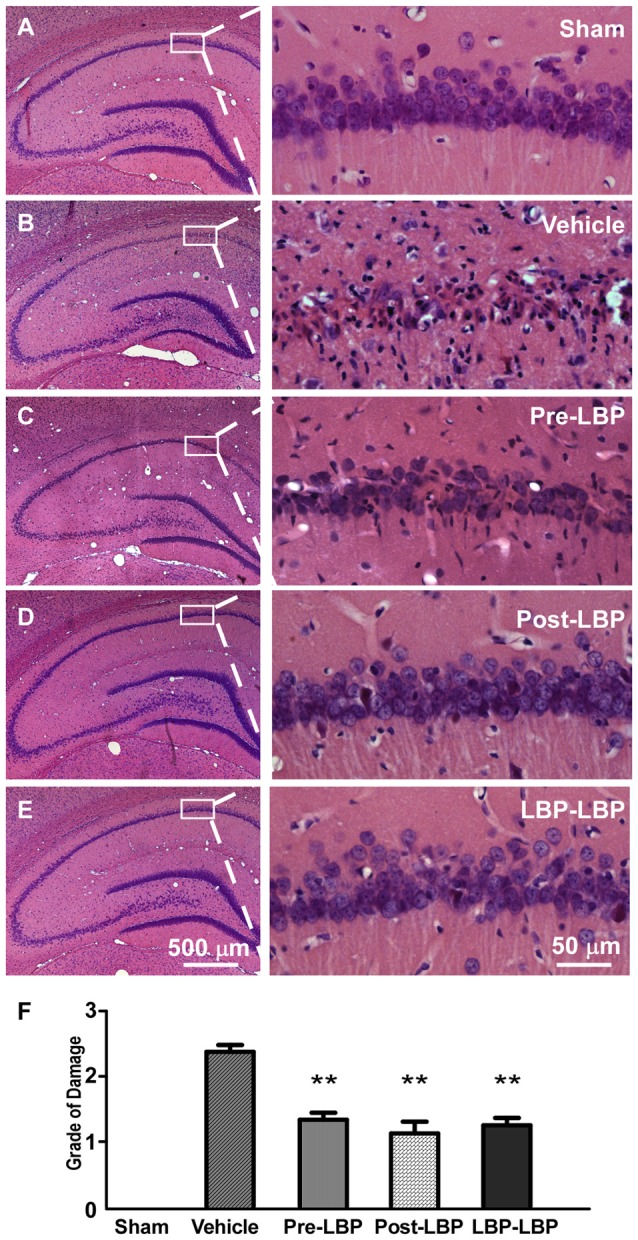
Hematoxylin-Eosin (HE) staining showing effects of Lycium barbarum polysaccharide (LBP) treatment on neuronal survival in the CA1 area. Morphological changes of neurons in different treatment groups are shown in representative pictures (A–E). Sham group, without four-vessel occlusion (4-VO) injury; Vehicle group, 4-VO insult only; Pre-LBP group, pretreated with LBP for 1 week before 4-VO; Post-LBP, 4-VO followed by LBP treatment for 1 week; and LBP-LBP, treatment with LBP for 1 week before and after 4-VO. Quantitative analysis is shown in (F) (n = 5. **P < 0.01).